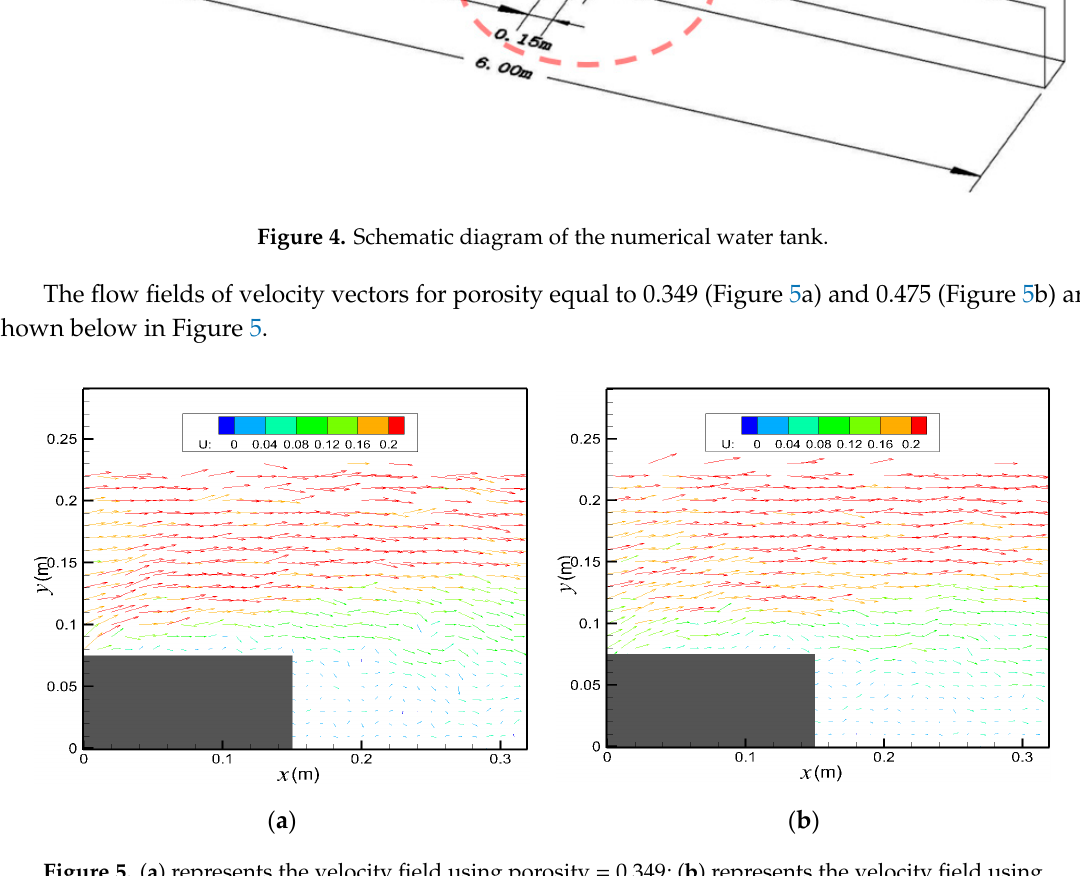
Figure 5. ( a ) represents the velocity field using porosity = 0.349; ( b ) represents the velocity field using porosity = 0.475. U: Longitudinal velocity (m/s).